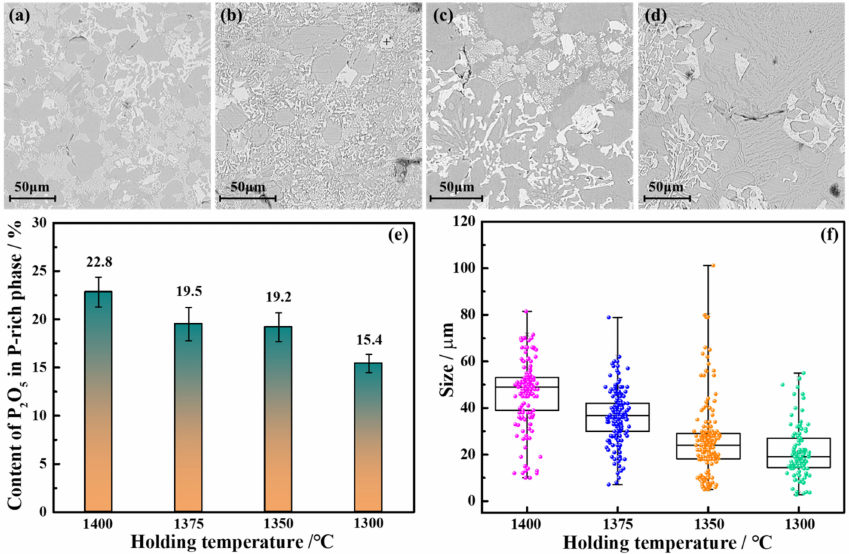
Figure 3. ( a – d ) Microscopic appearance of high phosphorus steel slag ( e ) P 2 O 5 content and ( f ) size of phosphorus-rich phase under different holding temperatures.